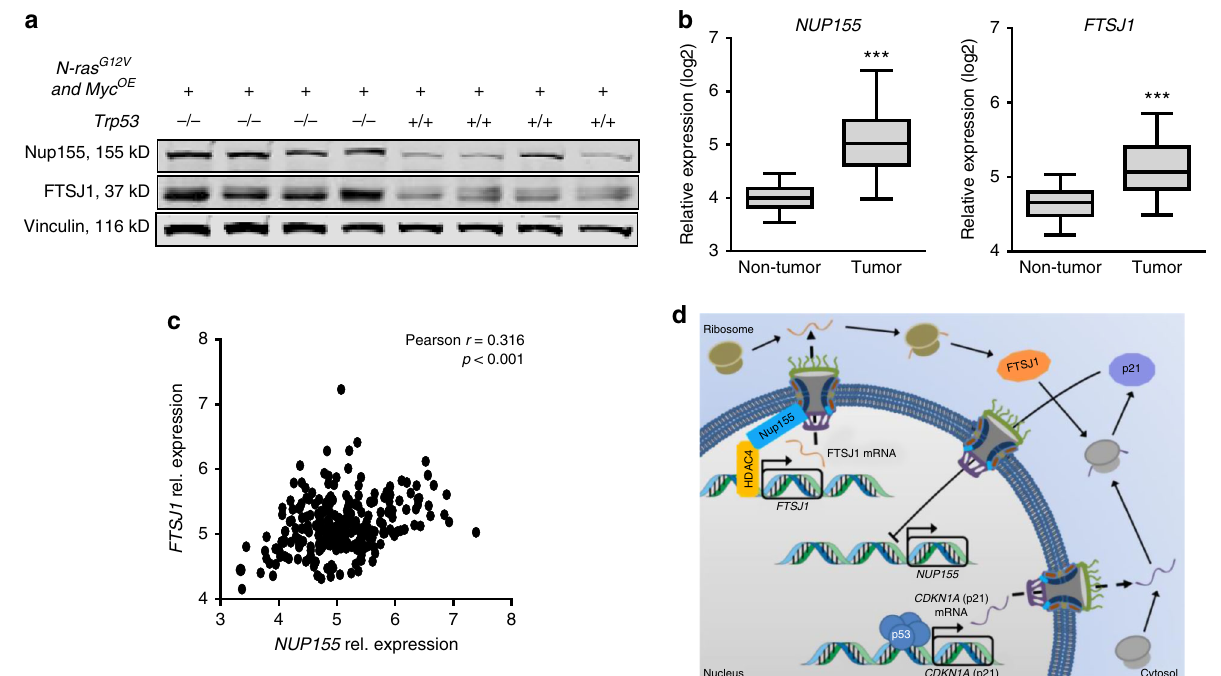
Fig. 7 p53 status, Nup155 and FTSJ1 expression are correlated in murine and human HCC. a Murine N-ras G12V and Myc- driven HCC which developed in a Tpr53 -deleted ( Trp53 − / − , n = 4 ) or -wild-type (Trp53 + / + , n = 4) background were analysed by immunoblotting with the indicated antibodies. b Relative transcript levels of NUP155 (left panel) and FTSJ1 (right panel), in HCC tissue ( n = 247) compared to non-tumorous liver tissue ( n = 239). The center line of the box plots denotes the median, the bounds of the box indicate the 25th to 75th percentiles and the whiskers represent the 5th to 95th percentiles, respectively. *** p < 0.001 (Student ′ s t -test). c Correlation of NUP155 and FTSJ1 in HCC tissue ( n = 247). r Pearson correlation coef fi cient, p Pearson p- value. d Suggested feedback loop model linking p53/p21 with Nup155 and FTSJ1. Source data are provided as a Source Data fi